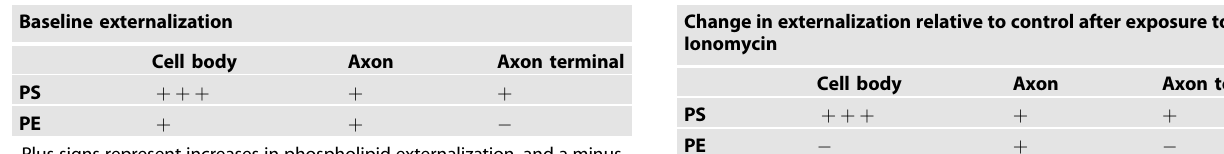
Fig. 1 Qualitative and quantitative changes in phospholipid externalization in cultured RGCs. A Externalization of PS and PE during apoptosis. PS and PE are preferentially distributed in the inner lea fl et of the plasma cell membrane of healthy cells. After apoptosis induction, membrane proteins are dysregulated, leading to externalization of PS and PE and a loss of membrane asymmetry. Externalized PS and PE are targets for imaging probes. B Timeline for cell imaging. Units are in minutes, with t = 0 the time point that ionophore or control media was added. The imaging probe mixture contained duramycin-GFP for imaging PE and annexin A5 for imaging PS. C Retinal ganglion cell before exposure to 12 uM ionomycin. Cells were in culture for 6 days prior to the experiment. Left: DIC image of cell. Middle: 670 nm image of cell, labeling PS externalization. Right: 519 nm image of cell, labeling PE externalization. D Retinal ganglion cell after 2 h exposure to 12 uM ionomycin. Left: DIC image of cell. Middle: 670 nm image of cell, labeling PS externalization. Right: 519 nm image of cell, labeling PE externalization. E Mean baseline PS and PE externalization in 20 RGCs for each cell compartment. Three measurements per cell were taken of each compartment. * p < 0.0001. F Change in PS externalization relative to baseline in 10 RGCs after 2 h exposure to 12 uM ionomycin or control media. For each cell 3 measurements were taken of each compartment. * p < 0.0001. G Change in PE externalization relative to baseline in 10 RGCs after 2 h exposure to 12 uM ionomycin or control media. For each cell 3 measurements were taken of each compartment. * p = 0.002. H Retinal ganglion cell before exposure to additional control media. Cells were in culture for 8 days prior to the experiment. Left: DIC image of cell. Middle: 670 nm image of cell, labeling PS externalization. Right: 519 nm image of cell, labeling PE externalization. I Retinal ganglion cell after 2 h exposure to additional control media. Left: DIC image of cell. Middle: 670 nm image of cell, labeling PS externalization. Right: 519 nm image of cell, labeling PE externalization. All scale bars 20 µm.